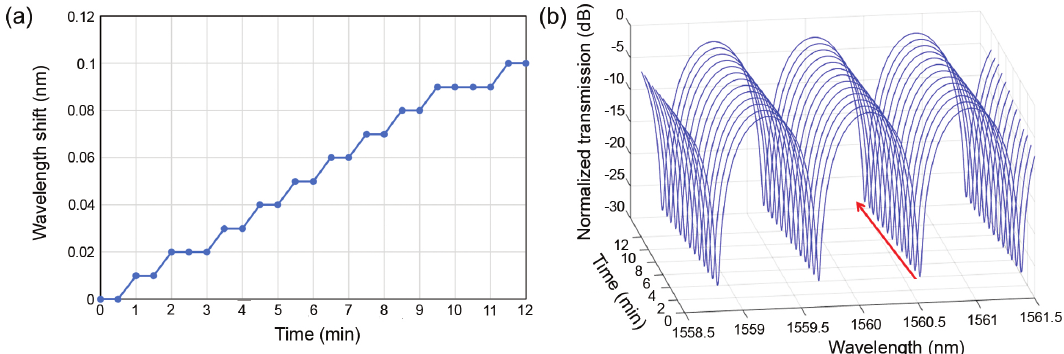
Figure 8. ( a ) BFL notch displacement vs. time, ( b ) BFL transfer function at different time instants. The red arrow shows the notch displacement in